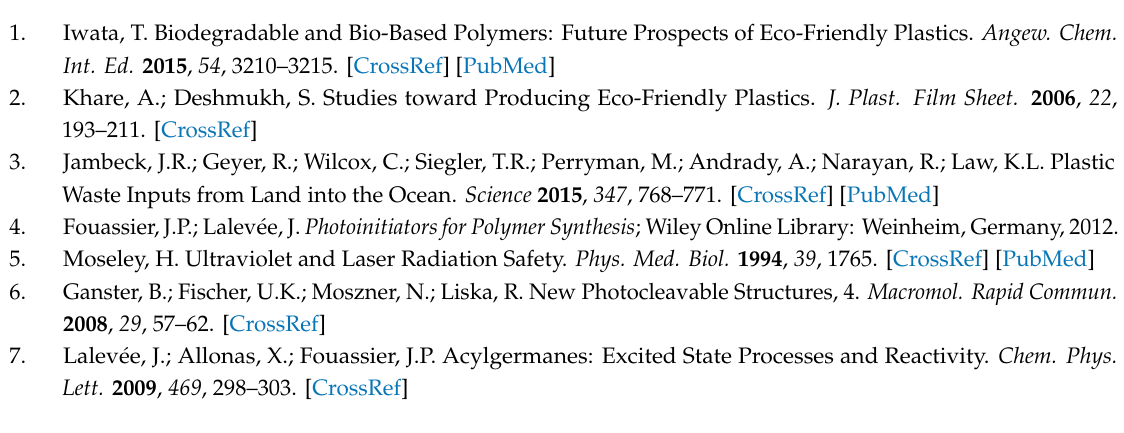
Figure S1: UV-vis spectra of (1) 4-dppba and (2) Ar 2 I + / PF 6 − in acetonitrile, Figure S2: (A) Photolysis of